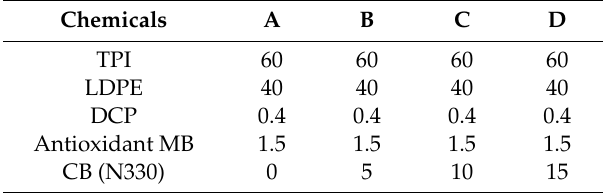
Table 1. Formulations of TPI / LDPE / CB composites (parts per hundred of